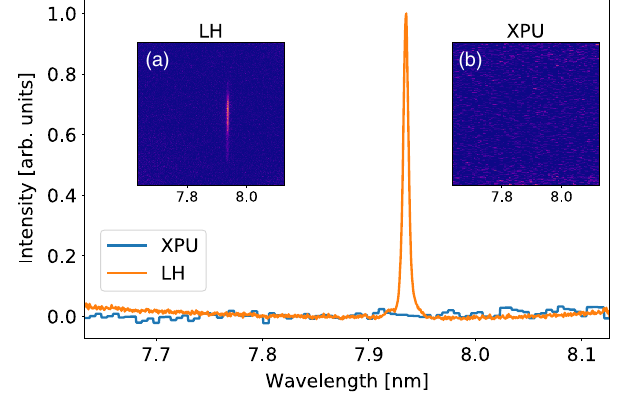
FIG. 17. Suppression of the harmonic signal in the XPU scheme. [orange curve and false color image in (a)] Third harmonic spectrum of the emission when the undulator is tuned in LH polarization and for the XPU alternated configuration, when two circularly polarized fields are superimposed in order to produce linearly polarized radiation [blue curve and image in (b)]. A harmonic signal is clearly present for the pure polarization state and not detectable in the XPU scheme. The intensities of the first harmonic were comparable in the two cases ( ∼ 20 μ J pulse energy). The spectra were accumulated for 11 shots in both cases. regime, employing the CR and CL polarization XPU scheme to produce linearly polarized radiation. The beam parameters were similar to those reported in [37], except for the final wavelength of 23.8 nm (gain length 1.6 m for the consecutive and 1.5 m for the distributed configuration), the same as for the seeding results reported earlier. In Fig. 18 the consecutive (top two panels) and the distributed configuration (bottom two panels) results are shown for the degree (blue) and direction of linear polarization (red).